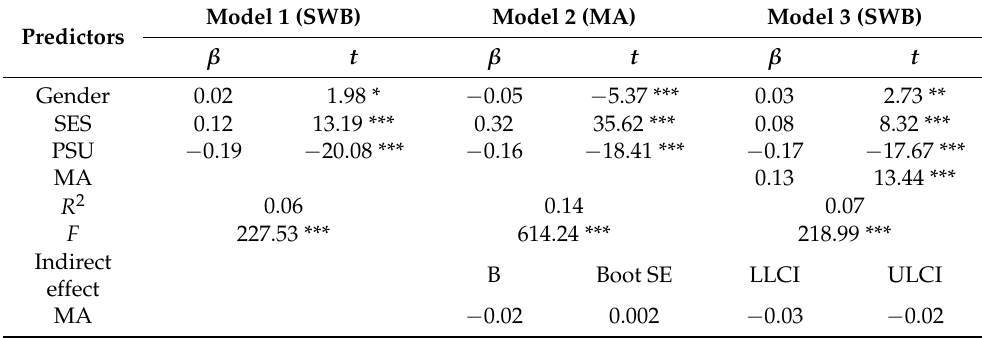
Table 2. Standardized coefficients for mediation effect